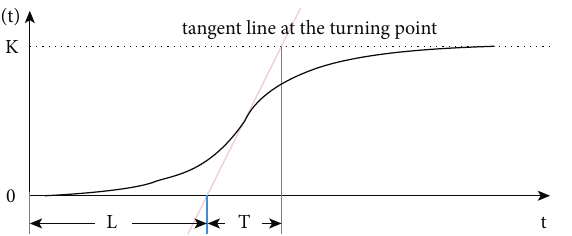
Figure 1: How to compute values corresponding to the gain K , the delay L , and the time constant T over the signal to control. Different methods can be applied to obtain ( K p , K i , K d ) parameters of the controller (see Tables 1–4). Table 1: The Ziegler–Nichols tuning rules create a quarter wave decay. This is an acceptable result for some purposes, but not optimal for all applications [49, 50].